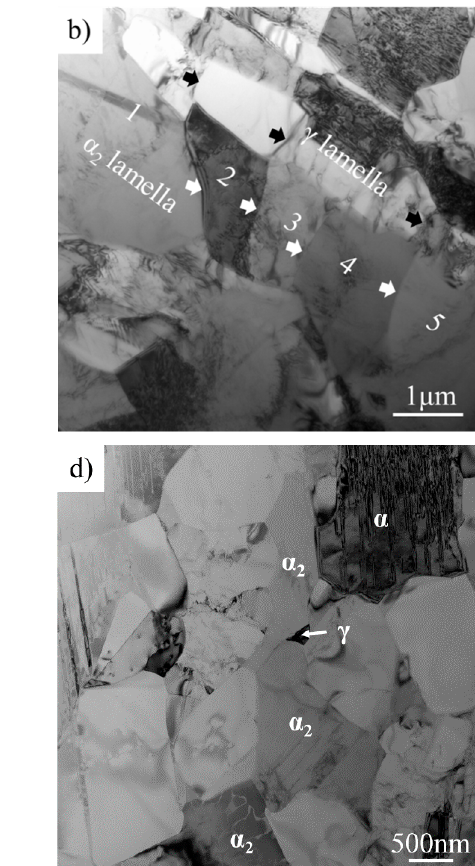
Figure 6. Local orientation maps and pole figures of the corresponding α 2 and γ grains in the black rectangle in Figure 4b: magnification of ( a ), ( b ) region 1, ( c ) region 2, and ( d ) region 3.